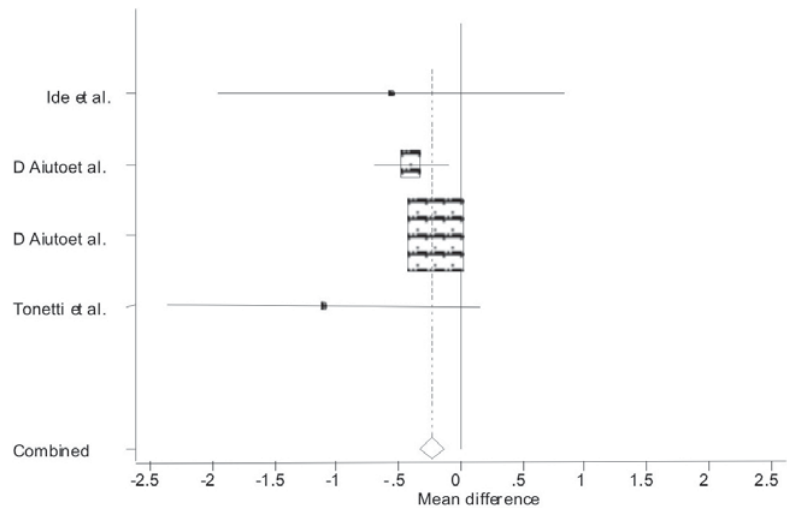
Figure 3- Changes in serum levels of C-reactive protein from before to after the periodontal